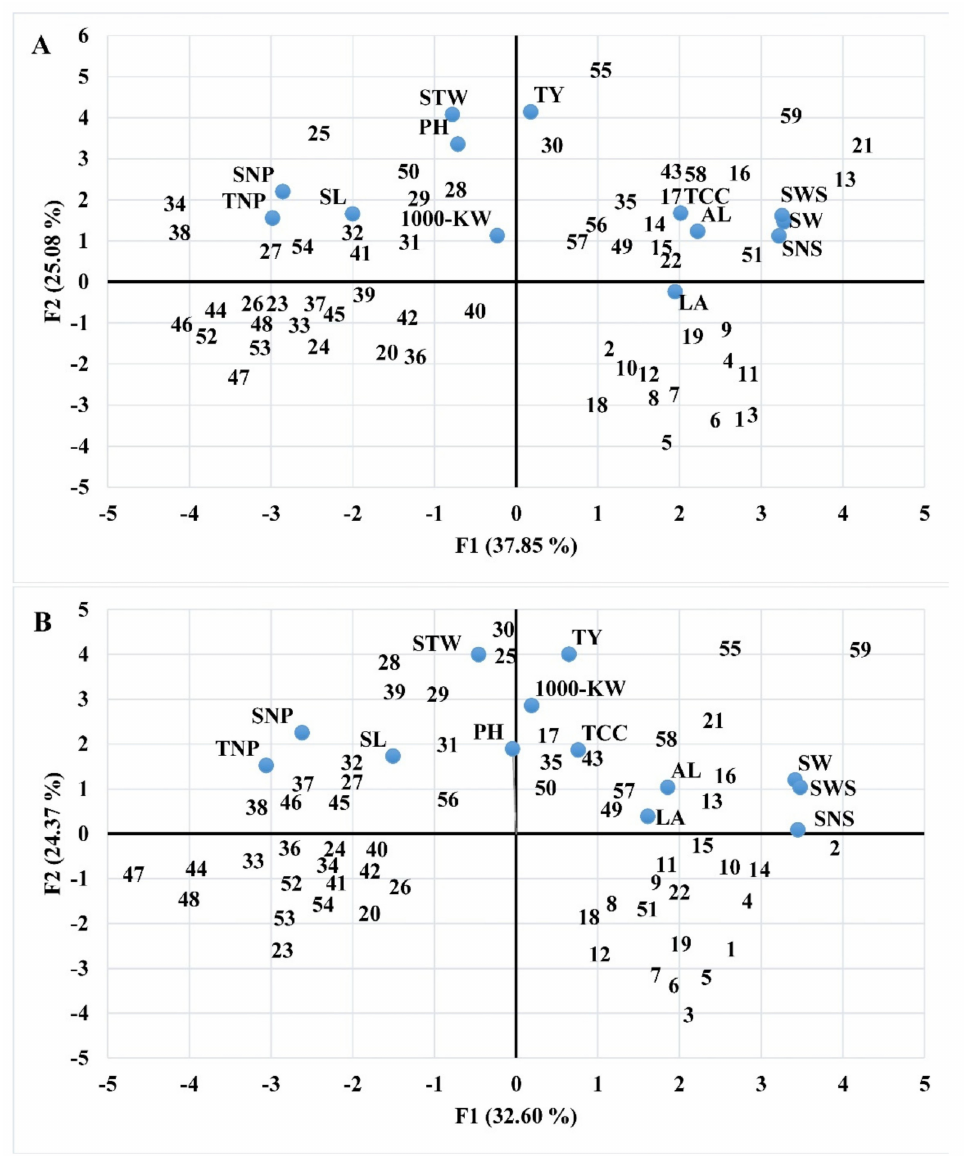
Figure 2. Biplot diagram of principal component analyses based on the first and second components for 59 barley accessions obtained from 13 morphological parameters under both control ( A ) and foliar application of moringa organ extract ( B ). PH: plant height, LA: leaf area, TCC: total chlorophyll content, TNP: number of the tiller per plant, SNP: number of the spike per plant, SL: spike length, AL: awan length, SW: spike weight, SNS: number of seeds per spike, SWS: seed weight per spike, 1000-KW: 1000-kernel weight, TY: total yield per plot, STW: straw weight. The numbers (1–59) represent the barley